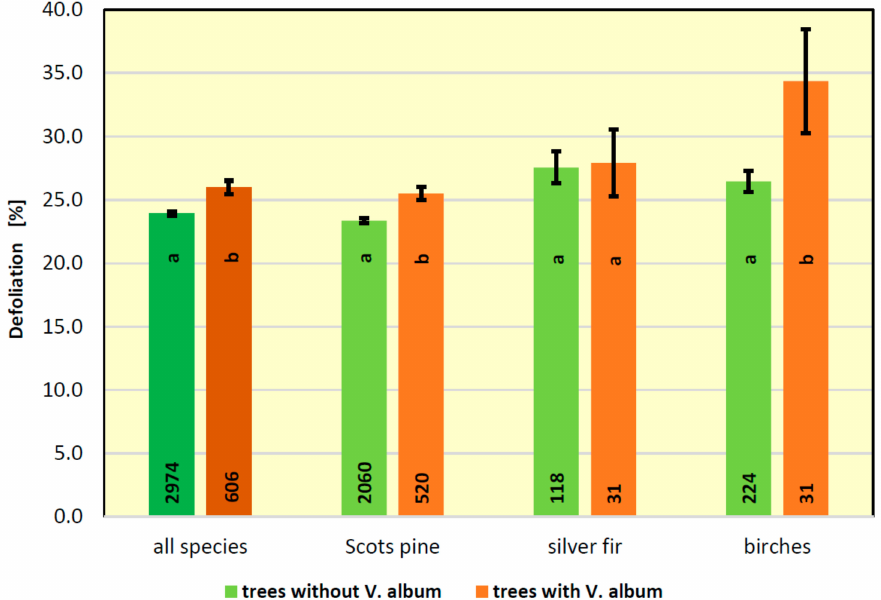
Figure 10. Average percentage defoliation of trees attacked by V . album and free from the parasite in the plots with mistletoe present, and the results of the Student’s t -test where “ab” denotes significant di ff erence between the means ( p ≤ 0.05), “aa”—not significant di ff erence between means ( p >